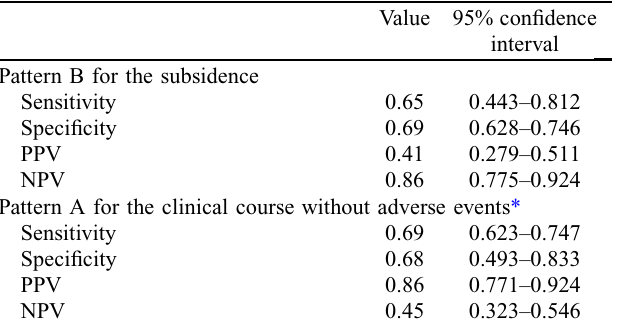
Table 2. Diagnostic accuracy of the acoustic analysis using Patterns A and